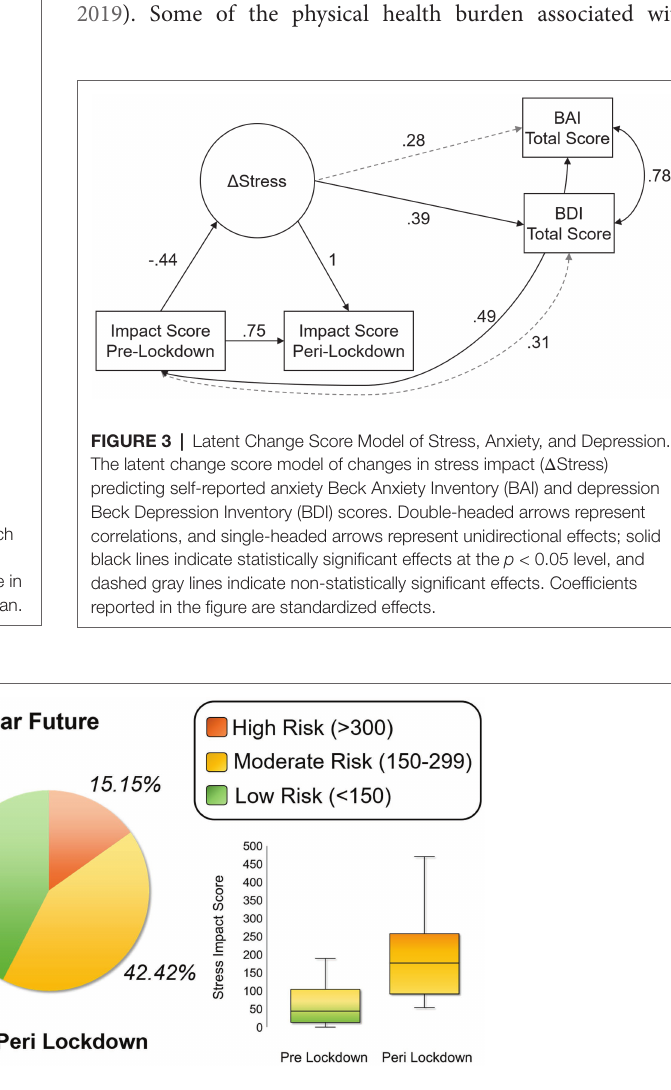
FIGURE 2 | Relative Risk of Stress-Induced Physical Illness in the Near Future. Pie charts showing the proportion of the sample of mothers who were at low risk (30% chance), moderate risk (50% chance) and high risk (80% chance) of contracting a physical illness in the near future based on stress impact scores computed from the Social Readjustment Rating Scale (SRRS) prior to lockdowns versus since lockdowns began. Box plots in the lower right corner demonstrate the distribution of total stress impact scores for the two time periods of interest.